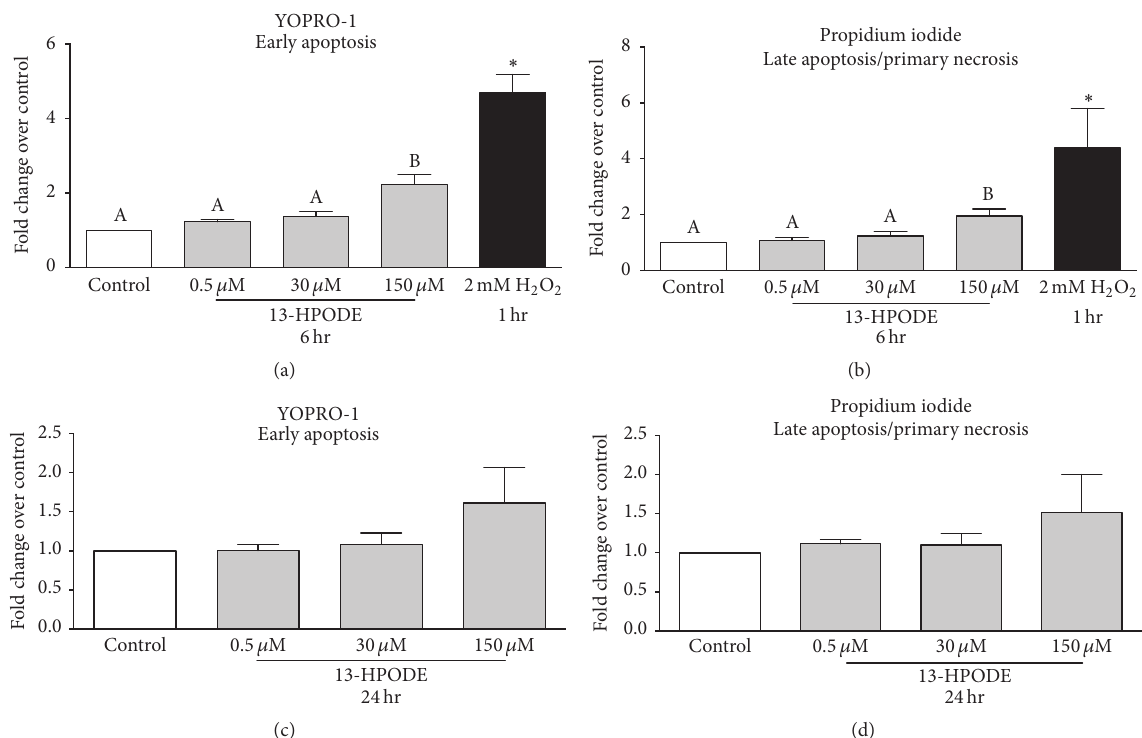
Figure 6: YOPRO (cid:2) -1 and propidium iodide of BMEC staining displayed as fold change over media control after 6 hr ((a) and (b)) and 24hr ((c) and (d)) 13-HPODE exposure. Media controls are displayed in open bars and 13-HPODE treatments are in light grey bars. Positive control (1hr 2mM H 2 O 2 exposure) YOPRO-1 and propidium iodide staining are displayed in (a) and (b) and are the black bars. Different letters demonstrate a significant difference among media control and 13-HPODE treatments determined by one-way ANOVA with Tukey’s post hoc correction. An asterisk ( ∗ ) represents a significant difference between medial control and H 2 O 2 as determined by Student’s t -tests. Significance declared at 𝑃 ≤ 0.05 .